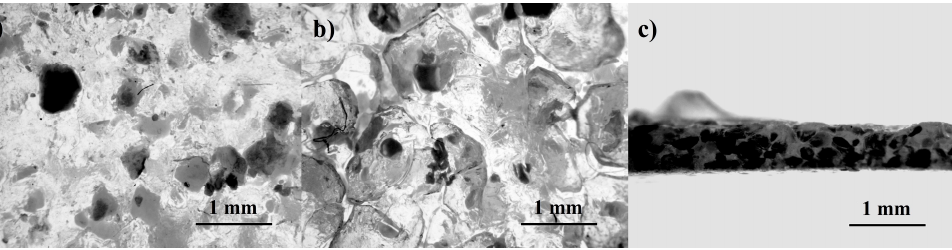
Figure 6. Images of 1st sample ( a ) surface before releasing, ( b ) surface after releasing, ( c ) side after releasing.